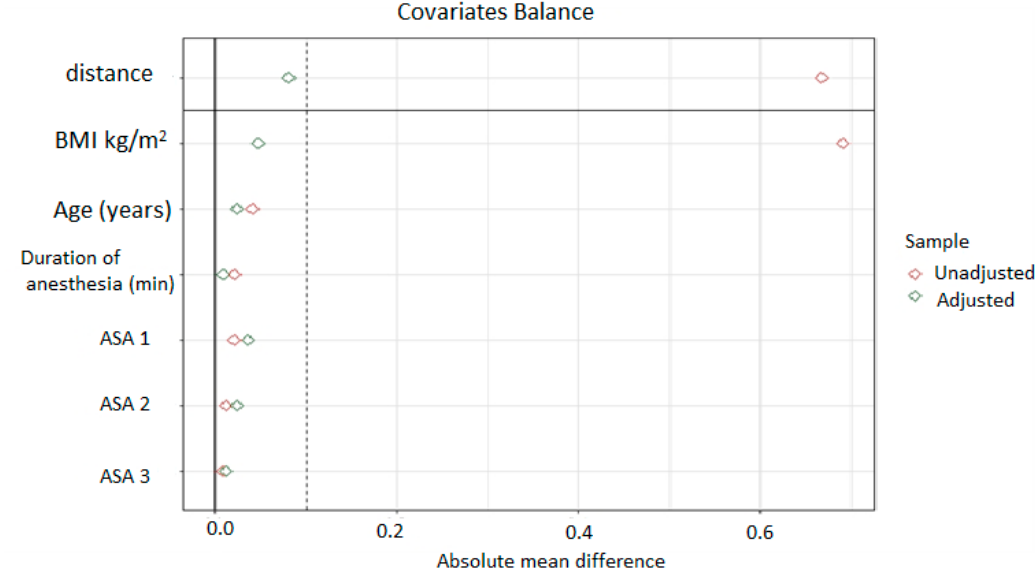
Figure 1. The plot represents the summary of covariate balance before and after matching. A standardized mean difference with absolute value (distance) less than 0.1 was considered an adequate reduction in the match imbalance. Dashed lines indicate standardized mean differences of − 0.1 and 0.1. Table 1. Patient characteristics comparison after matching.